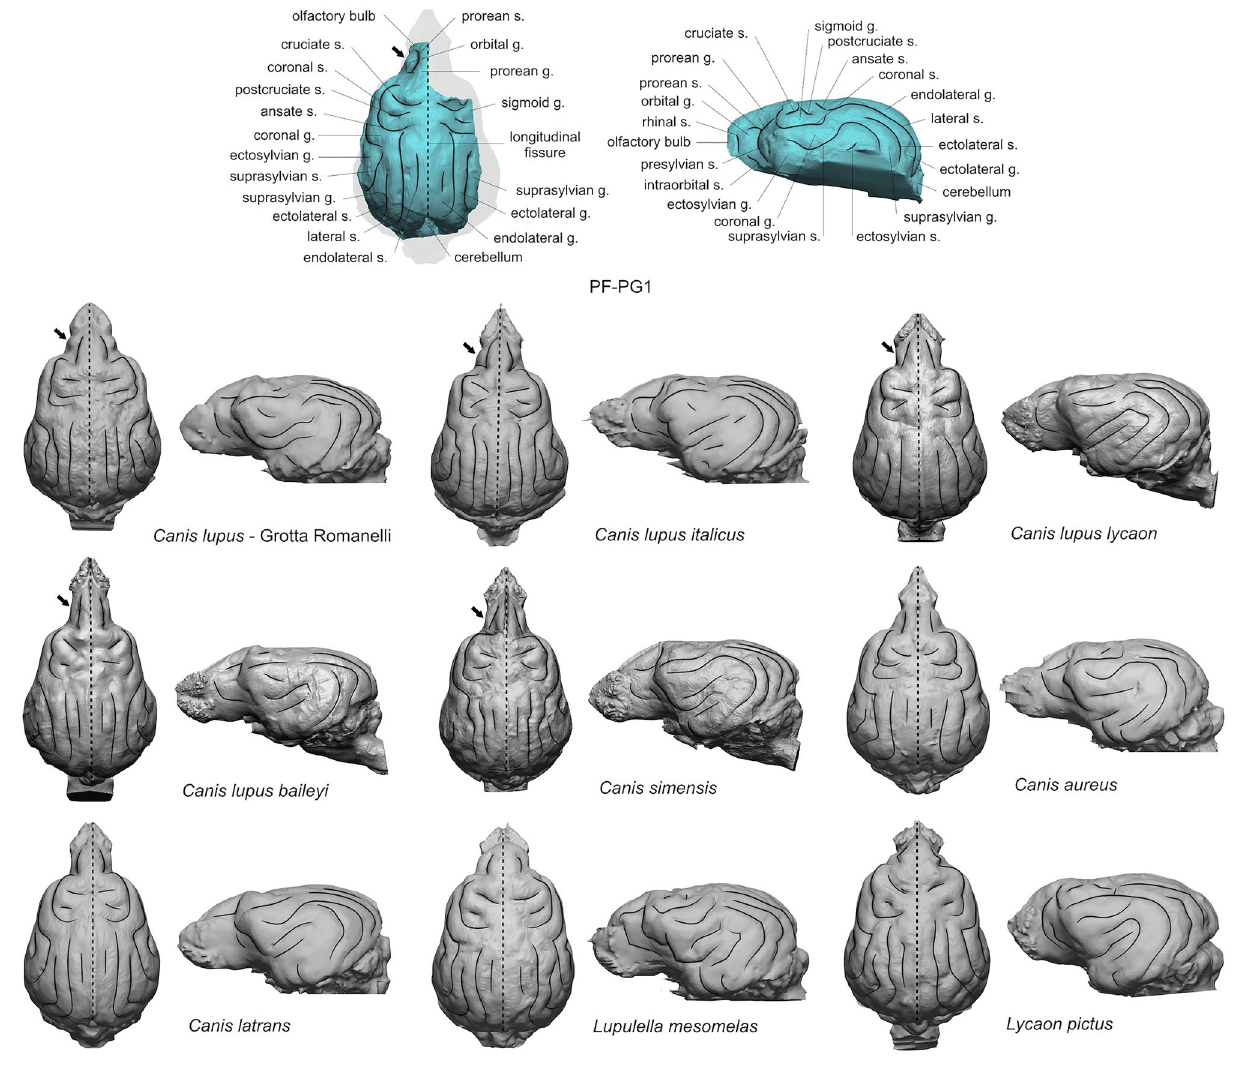
Figure 7. Comparative brain morphology of PF-PG1 specimen from Ponte Galeria and a selected sample of fossil and extant canids (the complete list of specimens is reported in Supplementary Table S5). The black arrows indicate a prominent orbital gyrus distinctive of Canis lupus and C. simensis . The sample is